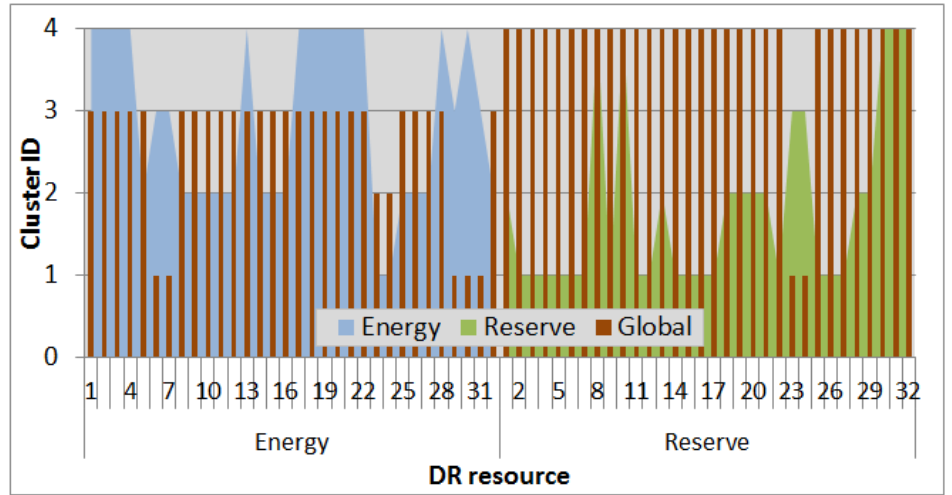
Figure 6. DR resources cluster